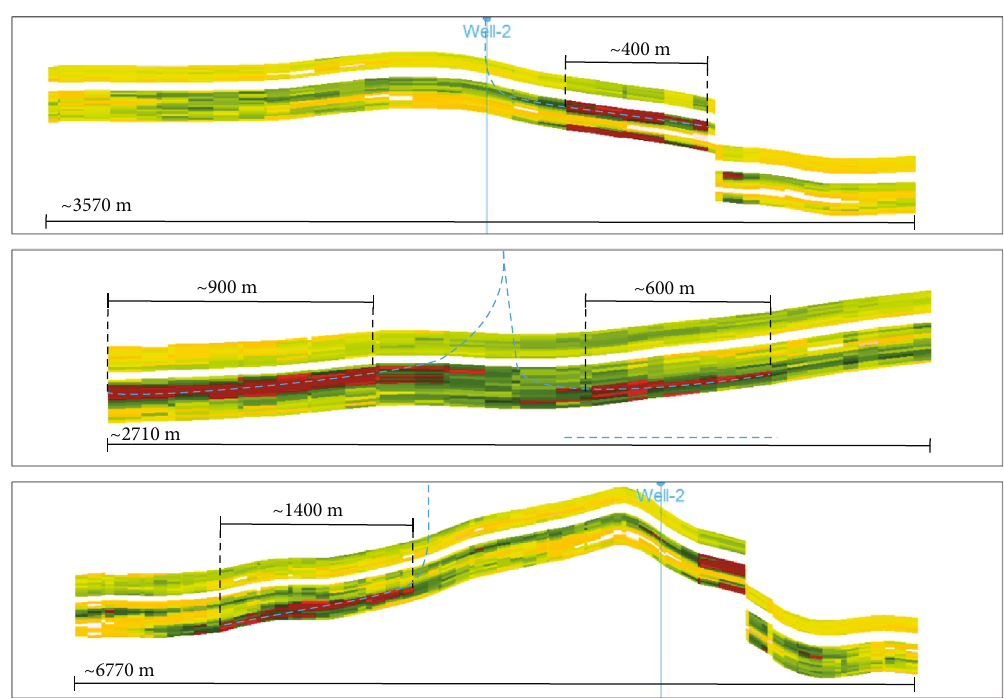
Figure 10: Cross-sections through the 3D distribution of calculated OIIP Free property. Such a form of result visualization provides a tool for 3D tracking of the most favorable zones or horizontal section designing to ensure sweet-spot